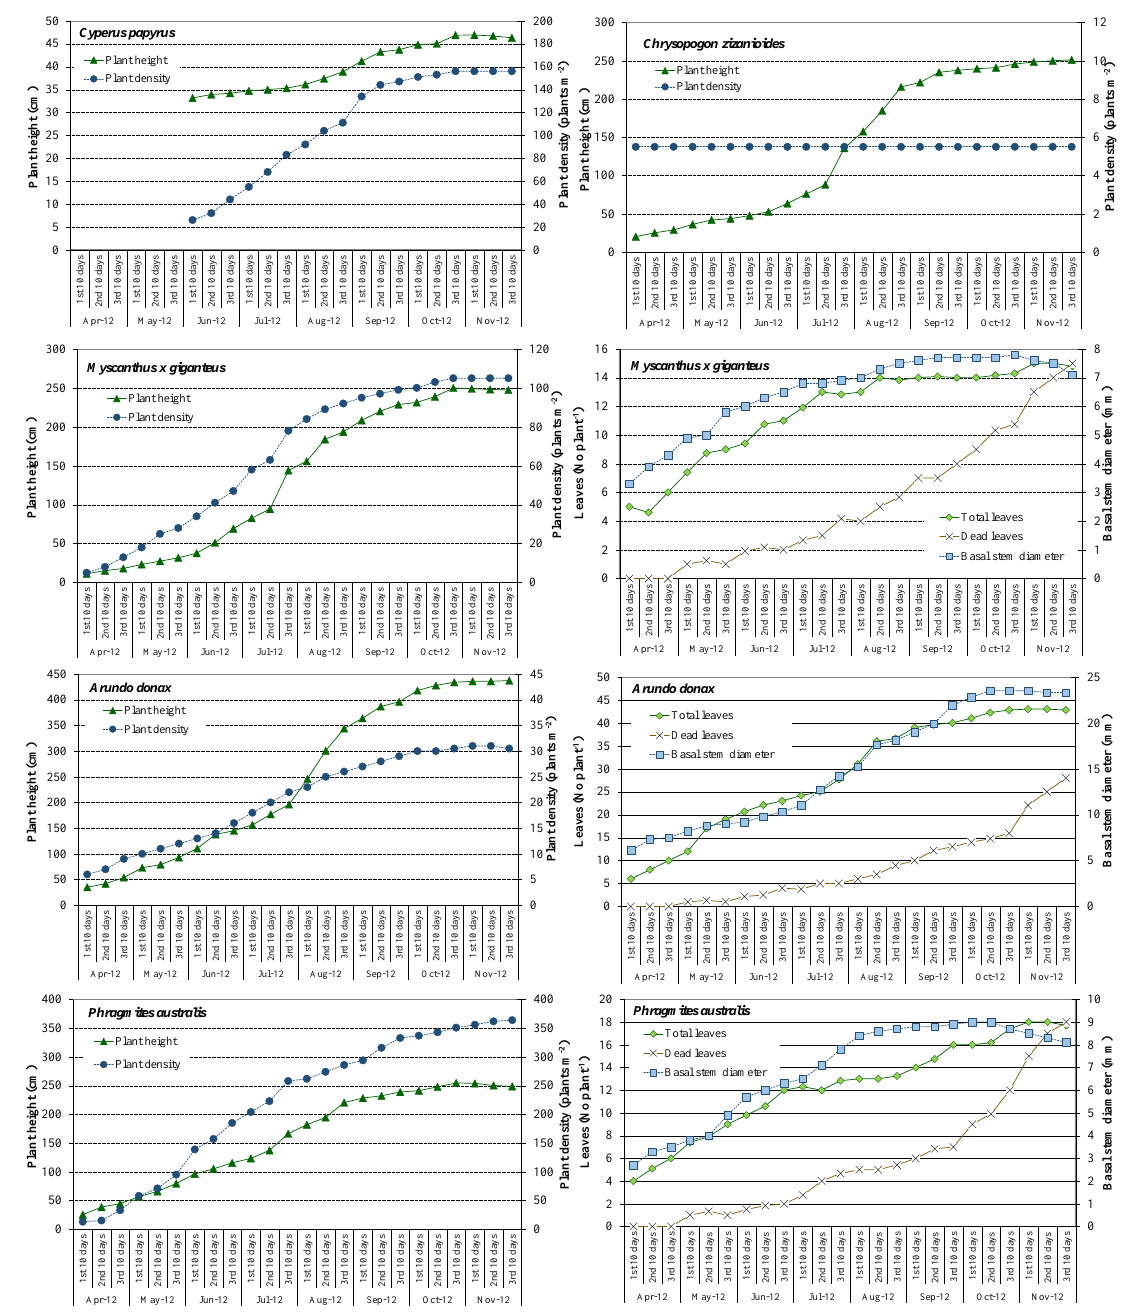
Figure 3. Trends of plant height and density (of C. papyrus, C. zizanioides, M. giganteus, A. donax, and P. australis ) and number of leaves (total and dead) and stem diameter (of M. giganteus, A. donax, and P. australis ) during 2012 growing season.